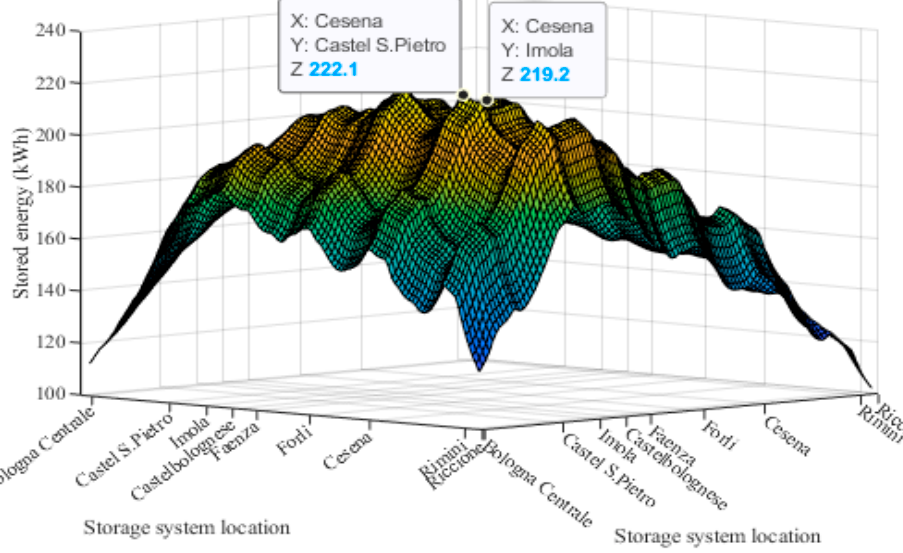
Figure 7. Recovered energy on varying the location of the two ESSs with the actual supply voltage level.